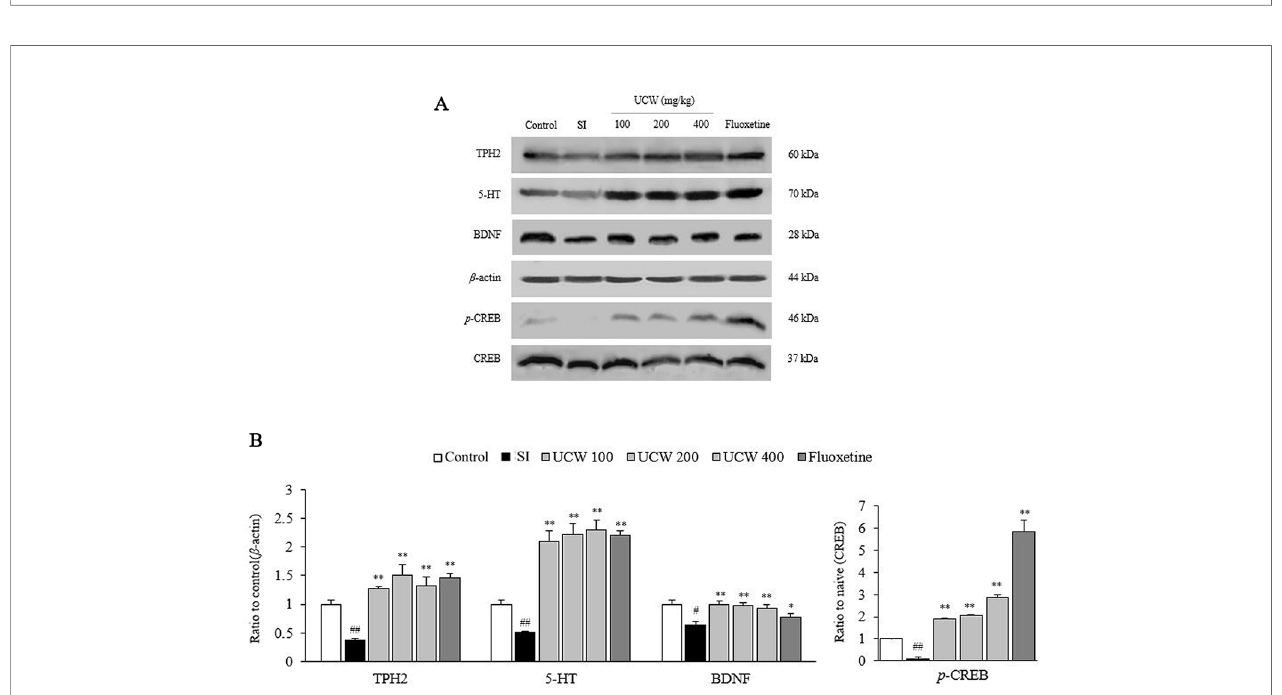
FIGURE 6 | Effects of UCW on TPH2, 5-HT, p -CREB, BDNF in the hippocampus. The TPH2, 5-HT, p -CREB, BDNF levels in the hippocampus were determined by western blotting (A) and quantitative aliases of them were analyzed (B) . Data are presented as the mean ± SD (n = 5). # P < 0.05, ## P < 0.01 compared the control group; *P < 0.05, **P < 0.01 compared with the social isolation (SI) group. TPH2, tryptophan hydroxylase 2; 5-HT, 5-hydroxytryptamine; BDNF, brain-derived neurotrophic factor; CREB, cAMP response element-binding protein; p -CREB, phosphorylated cAMP response element-binding